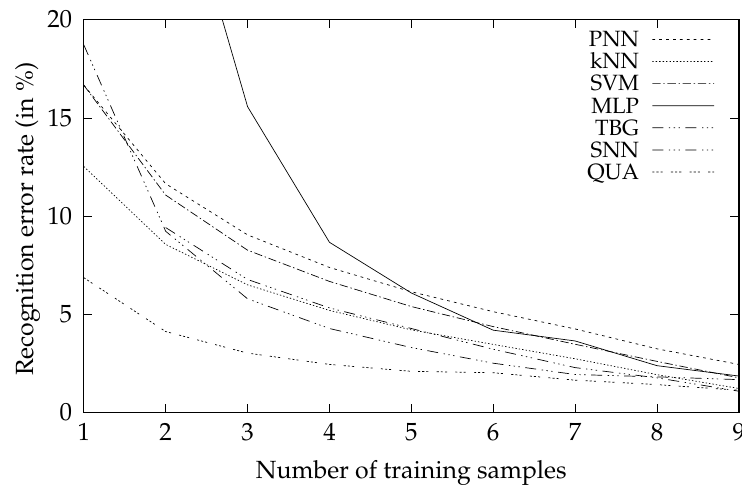
Figure 2. Dependence of the average error rate of different classifiers in the problem of person recognition on the number of training samples per class n .